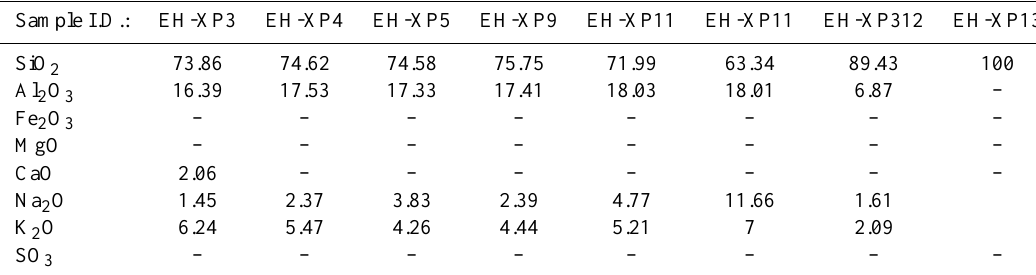
Table 2. Representative EDX analysis of El Hierro “restingolite” glasses. Sample